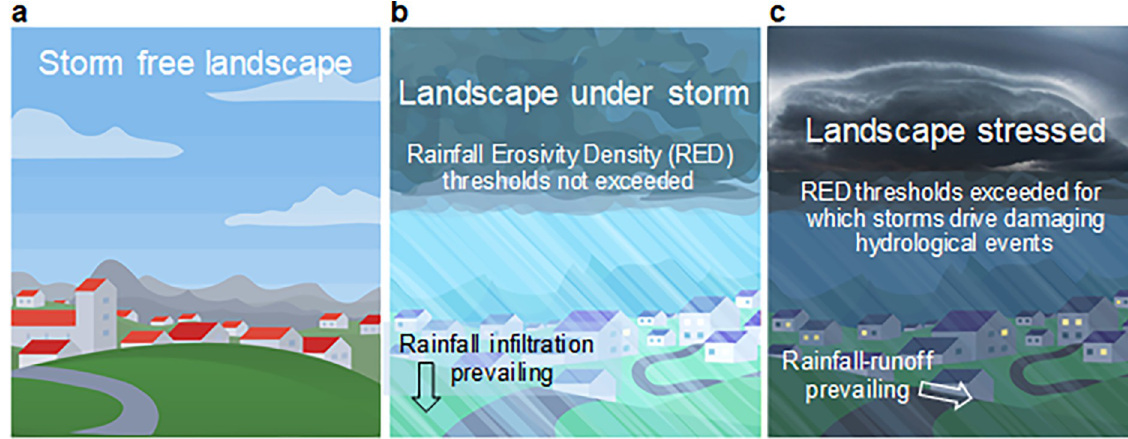
Fig 2. Landscape under different weather regimes with changing RED thresholds for a given level of hydrological disturbance in: a) Storm-free landscape, b) Landscape under storms not exceeding thresholds, and c) Stressed landscape where thresholds are exceeded resulting in damaging hydrological events (image arranged from MeteoBlue, https://static.meteoblue.com/assets/images/crosslinks/yearcomparison.svg).